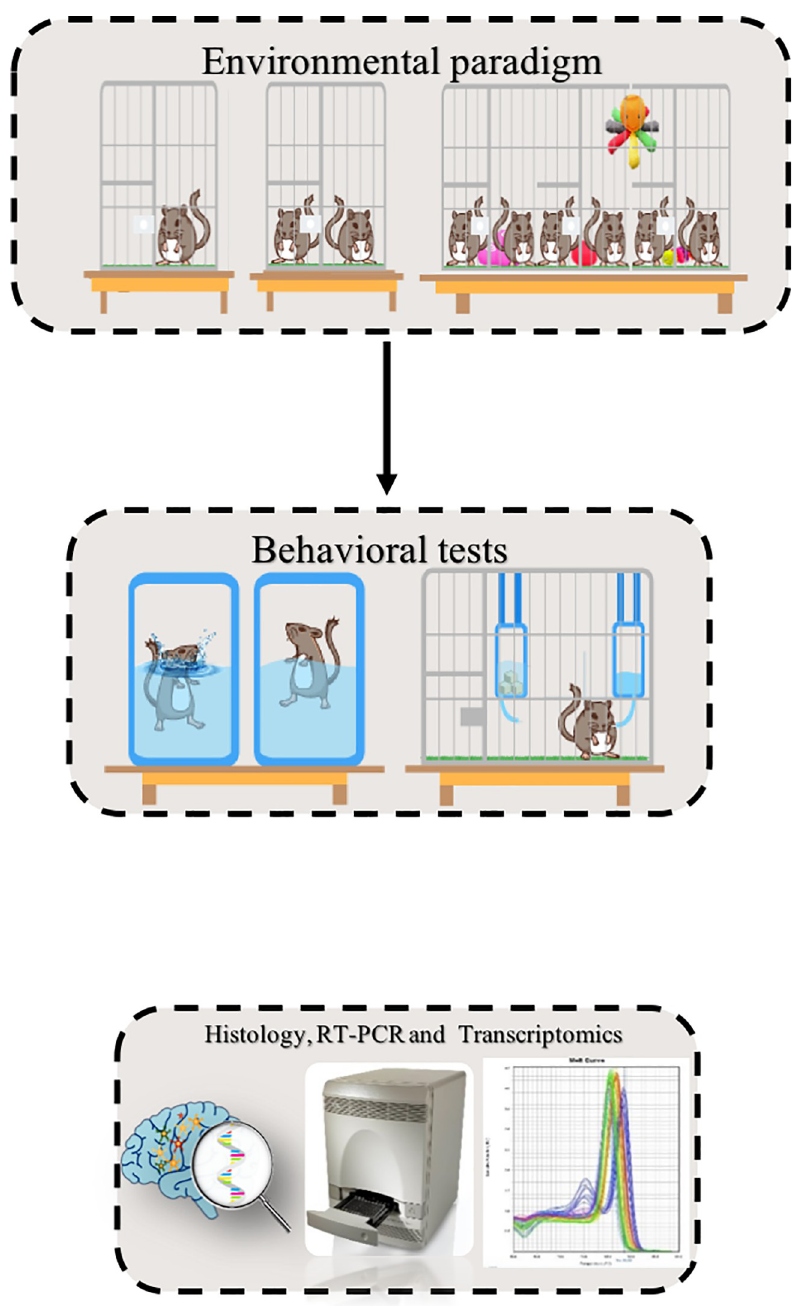
Fig 1. Schematic representation of the study